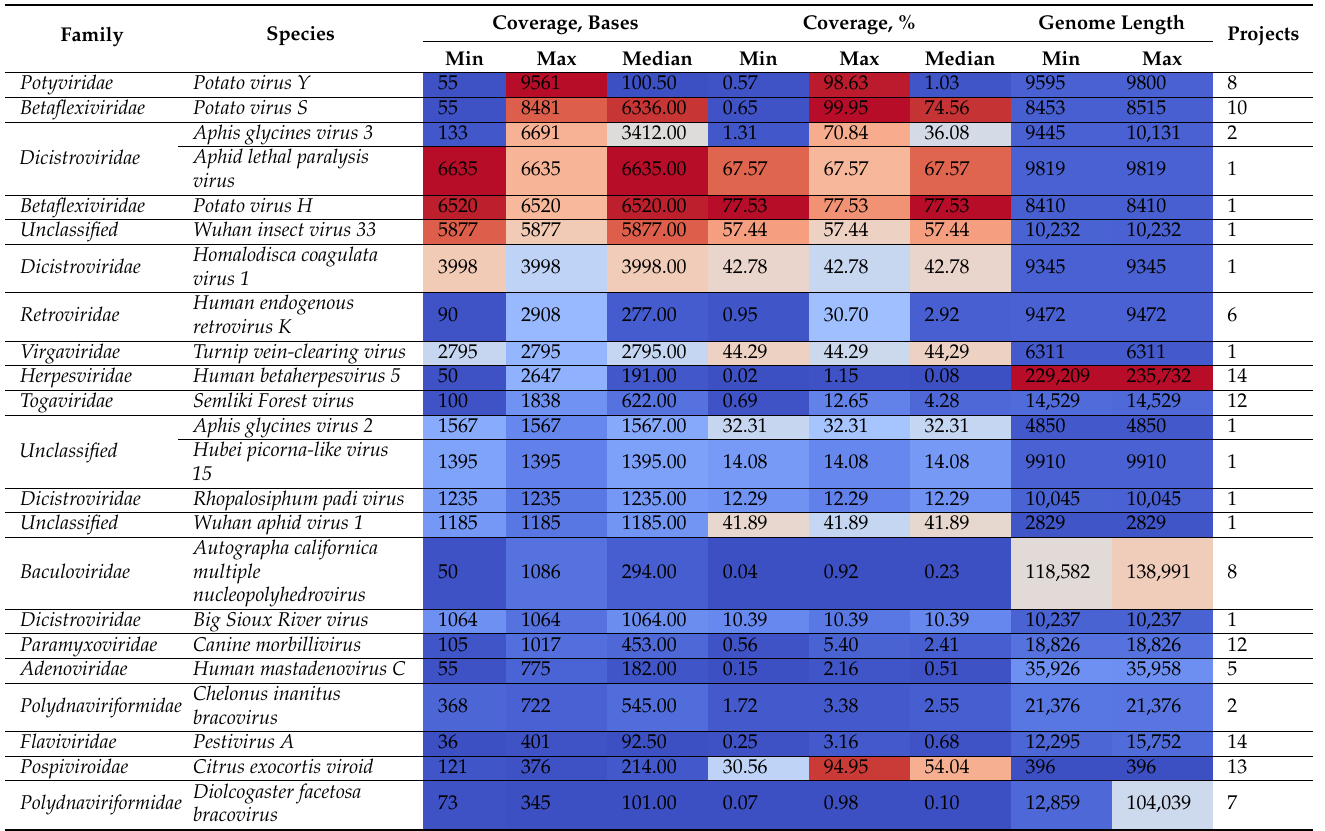
Table 2. Characteristics of reads’ alignments to viral genomes. This table specifies the family, genus, and species of the virus, genome coverage information (maximum, average, and median, in nucleotides and percentages), the minimum and maximum genome lengths stored in the BigViralDB database for the specified viral family, and the number of L. decemlineata genomic and transcriptomic projects where these viral sequences were